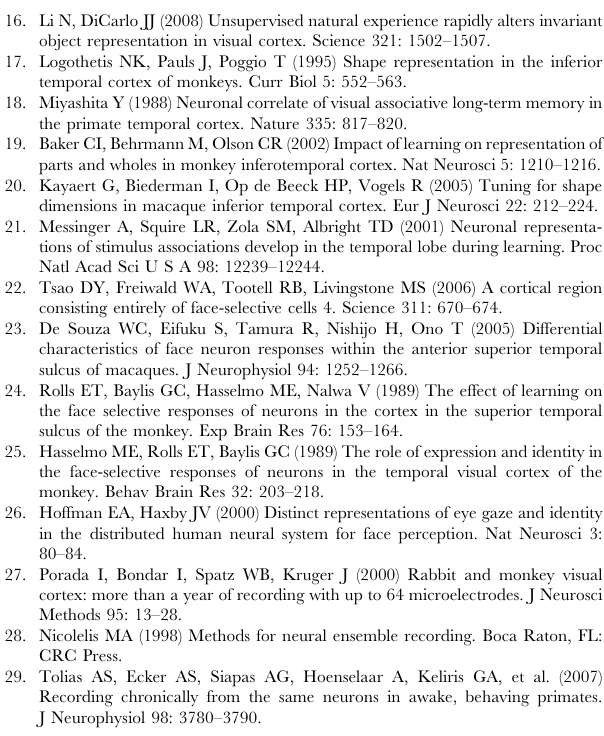
mortem T2-weighted scan for N97 and anesthestized T1-weighted for E98) of the recording positions in the two monkeys. The red arrows show the position of electrodes tips in the brain tissue. Figure S4 Details in the monitoring of single unit activity over time with the chronic multielectrode bundle during 20 recording sessions in monkey E98 (A) and 53 sessions in monkey N97 (B). The color code corresponds to the number of simultaneously recorded neurons on one electrode. Deep blue corresponds to the absence of spiking activity on the electrodes. Extended periods of deep blue ranging over all channels correspond to absence of recording in particular time period. Figure S5 Distribution of spike parameters for putative stably isolated neurons (black) and neurons recorded during the same session (grey). A. Distributions were computed between normal- ized inter-spike time histograms calculated on the basis of neuronal activity recorded form same neuron on two consecutive recording sessions (black) and between different neurons recorded on the same wire (grey). Small values for Euclidian distances demonstrate high degree of similarity between characteristic features of spiking activity. B. Color coding is same as in A. In this case Euclidian distances were calculated between average spike waveforms. Normalized spike waveforms showed higher degree of similarity in case of stably recorded cells. Figure S6 Complete responses from a single neuron (second neuron in Fig. 1a) to all stimuli over a period of 17 days. Each action potential is depicted by a small point, with different colors